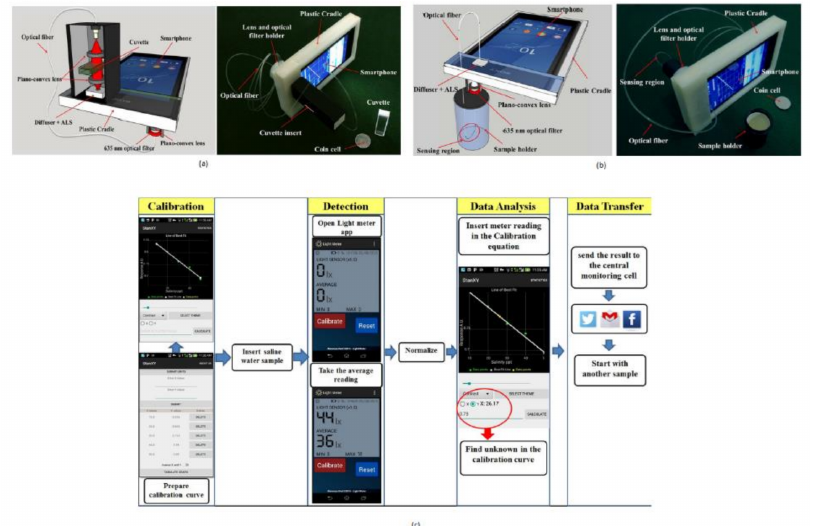
Figure 12. ( a ) Salinity detection using direct transmission smartphone-based approach.( b ) Smartphone- based salinity detection using evanescent field absorption approach. ( c ) Steps involved in measuring salinity in water. Figure adapted with permission from [19]. The salinity detection and analysis are performed on two different Android